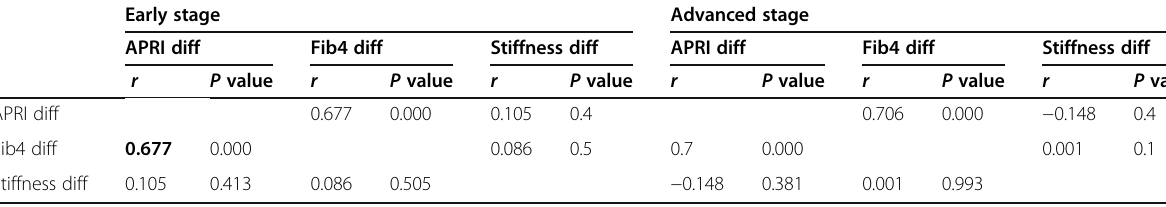
Table 4 Correlation between change in APRI, FIB4, and LSM Early stage Advanced